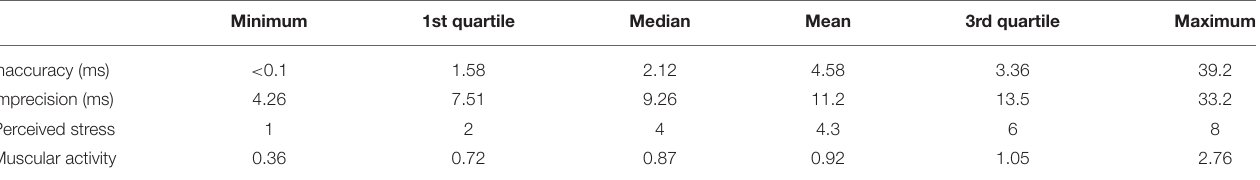
TABLE 2 | Summary of the measurement data.